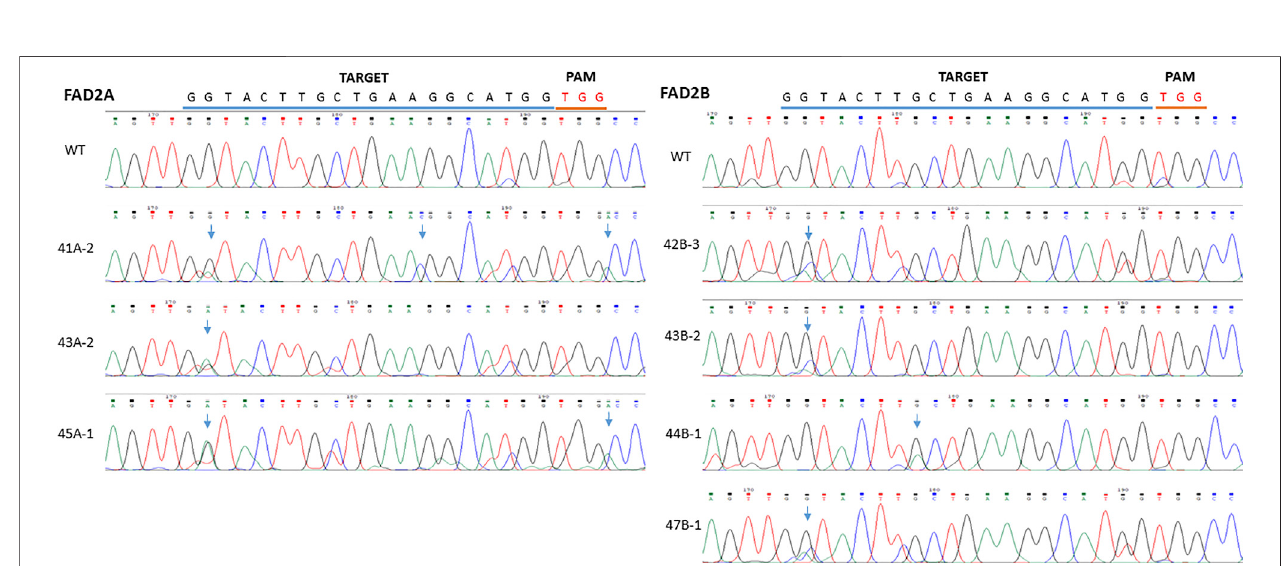
FIGURE4| Comparison ofmutationsbetweendifferent inoculated sampleswithvector pDW3873attargetsof FAD2A and FAD2B using hairyroottransformation for the CDS target. The blue line refers to gRNA and the red line indicates PAM. There was one base change (G > A) at the base position 2 within the target, one insertion (C)occurringbetweentheposition13and14,andanotherinsertion(A)inducedjustnexttothePAMin FAD2A ,whiletwopotentialbasechanges(G > CorA)atposition2 and (G > A) at position 8 in the target of FAD2B .